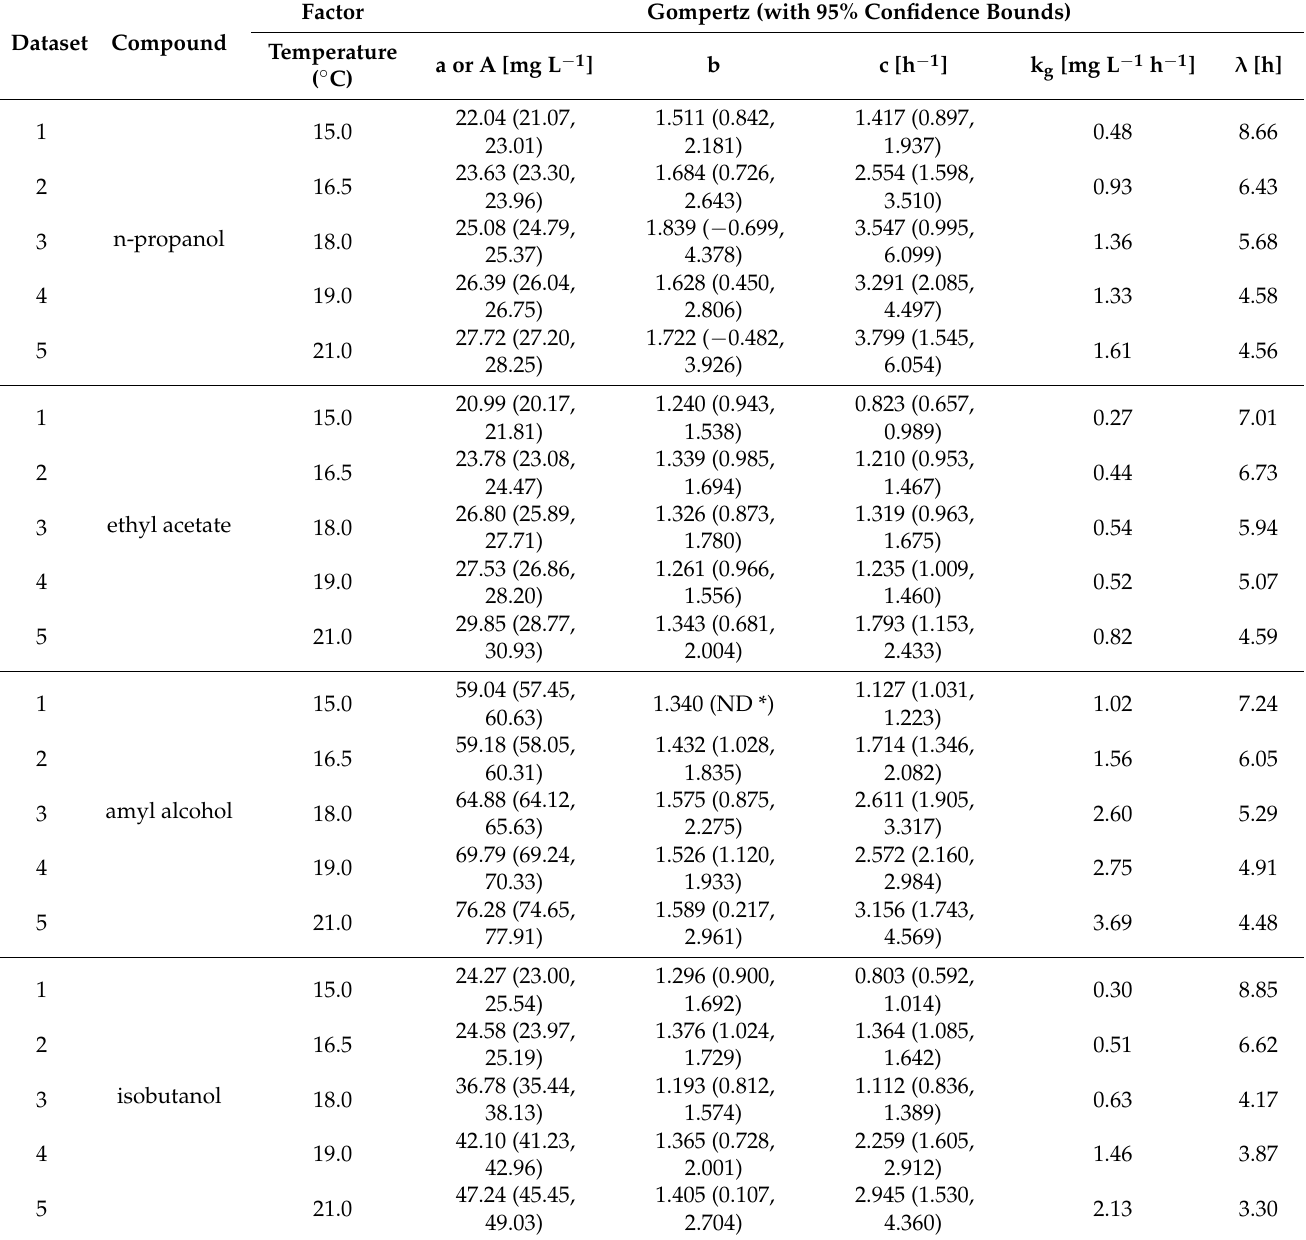
Table 2. Estimated mathematical parameters for Gompertz functions for n-propanol, ethyl acetate, amyl alcohol and isobutanol, for different temperatures. A is the asymptote; k g represents the specific maximum growth rate; λ is the lag time. Data in parentheses represent 95% of confidence